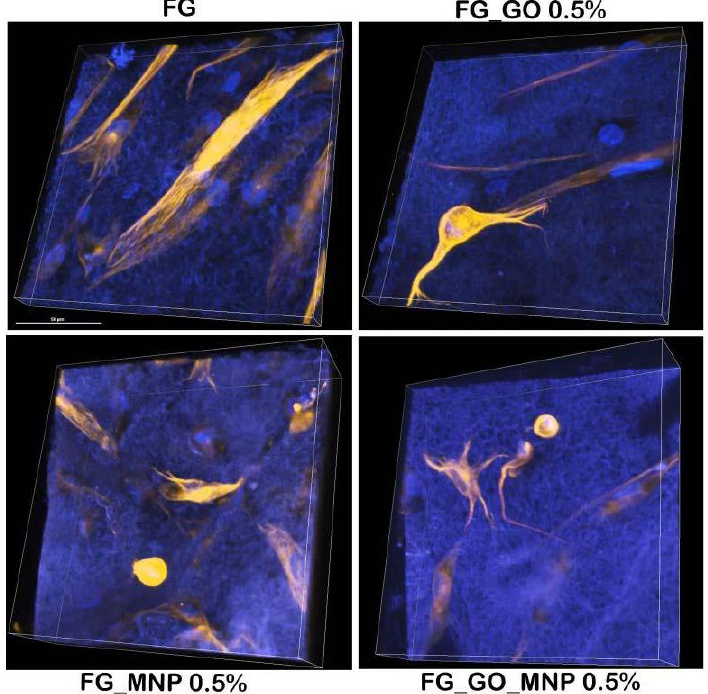
Figure 8. Immunofluorescence of the neuronal marker β -III-tubulin (marked with AF546 in orange, nuclei are marked with Hoechst33342 in blue) expressed in hASC/FG biosystems after 10 days of in vitro neuronal differentiation. Scale bar = 50 µm.